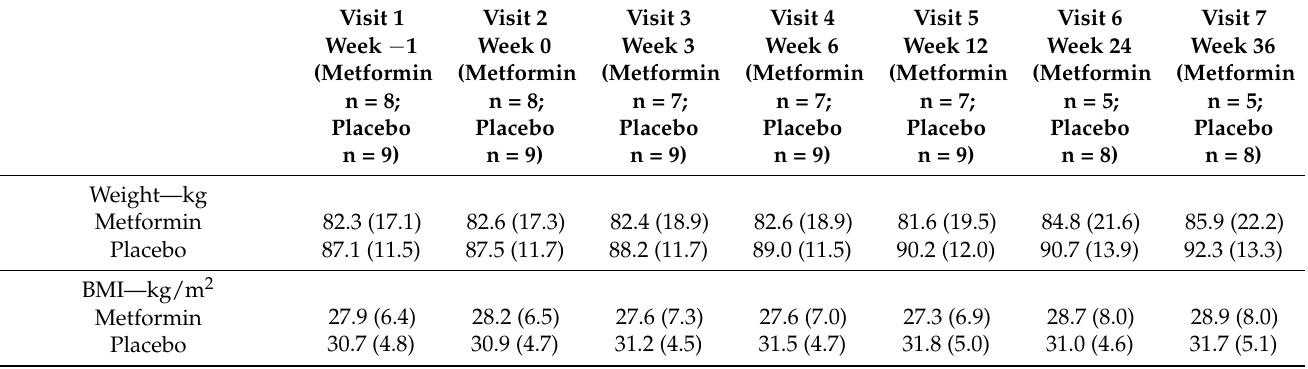
Table 3. Clinical parameters of the enrolled participants over time, represented as the mean